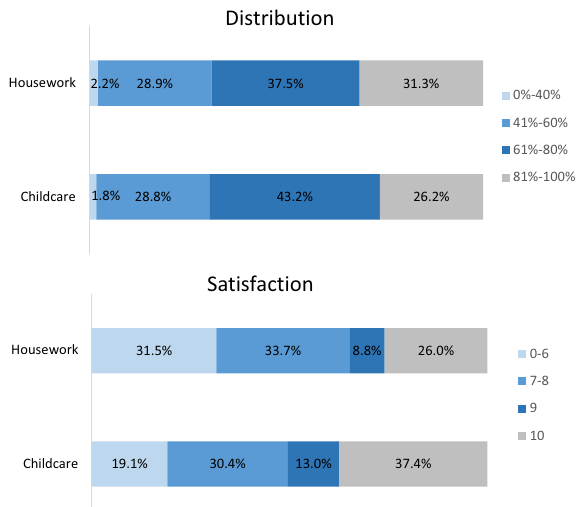
Fig. 1 Percentage of housework and childcare duties performed by women and reported satisfaction levels. Percentages are